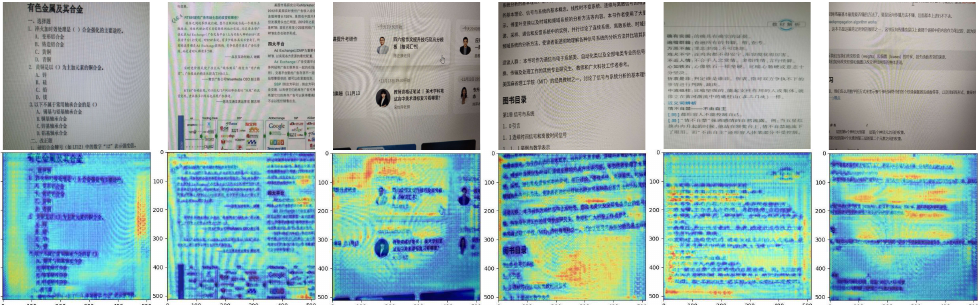
Figure 6. The total visualization results of the four spatial domain demoiré blocks. The first row is the original moiré images. The second row is the Grad-CAM results.